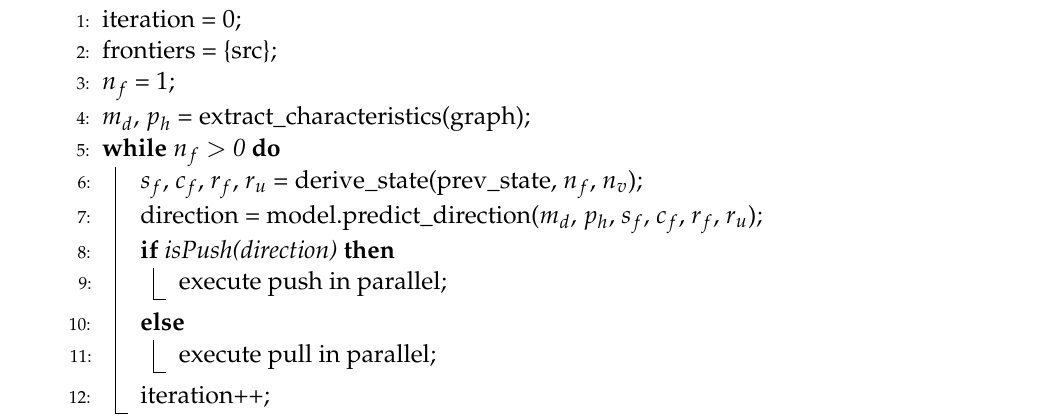
Algorithm 7 Workload state-based direction-optimizing BFS.